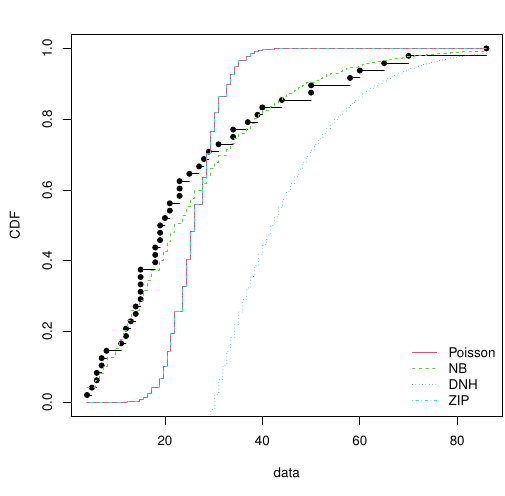
Figure 5 – Empirical CDF plot for the data on examination marks in mathematics.